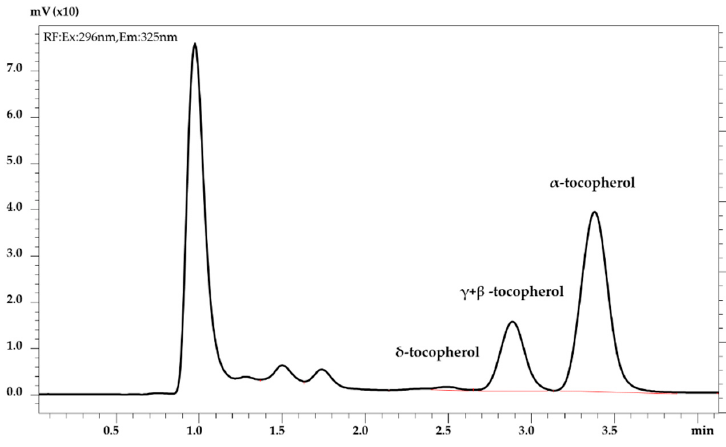
Figure 2. UHPLC-FL trace of tocopherols in lampante olive oil